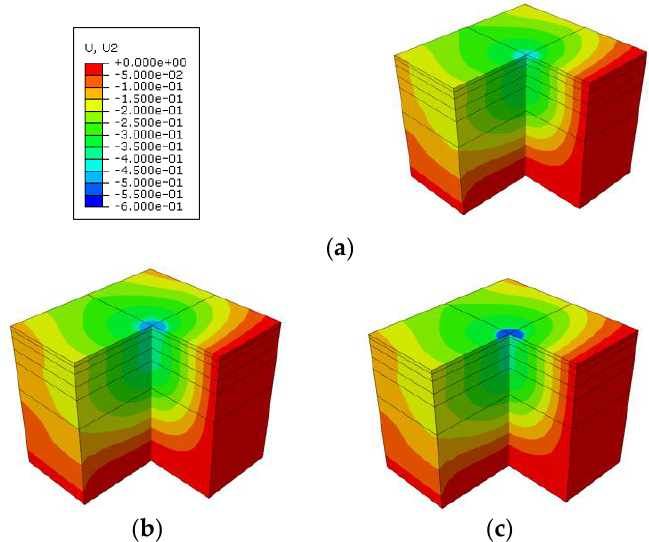
Figure 7. Distribution of the vertical displacement at different moments: ( a ) 6 h, 24.7 ◦ C; ( b ) 22 h, 30.2 ◦ C; and ( c ) 13 h, 50.1 ◦